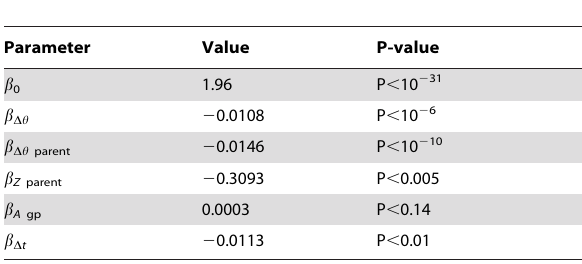
Table 2. Multiple logistic regression results evaluating the effects of observed trends on pseudopod zig-zag